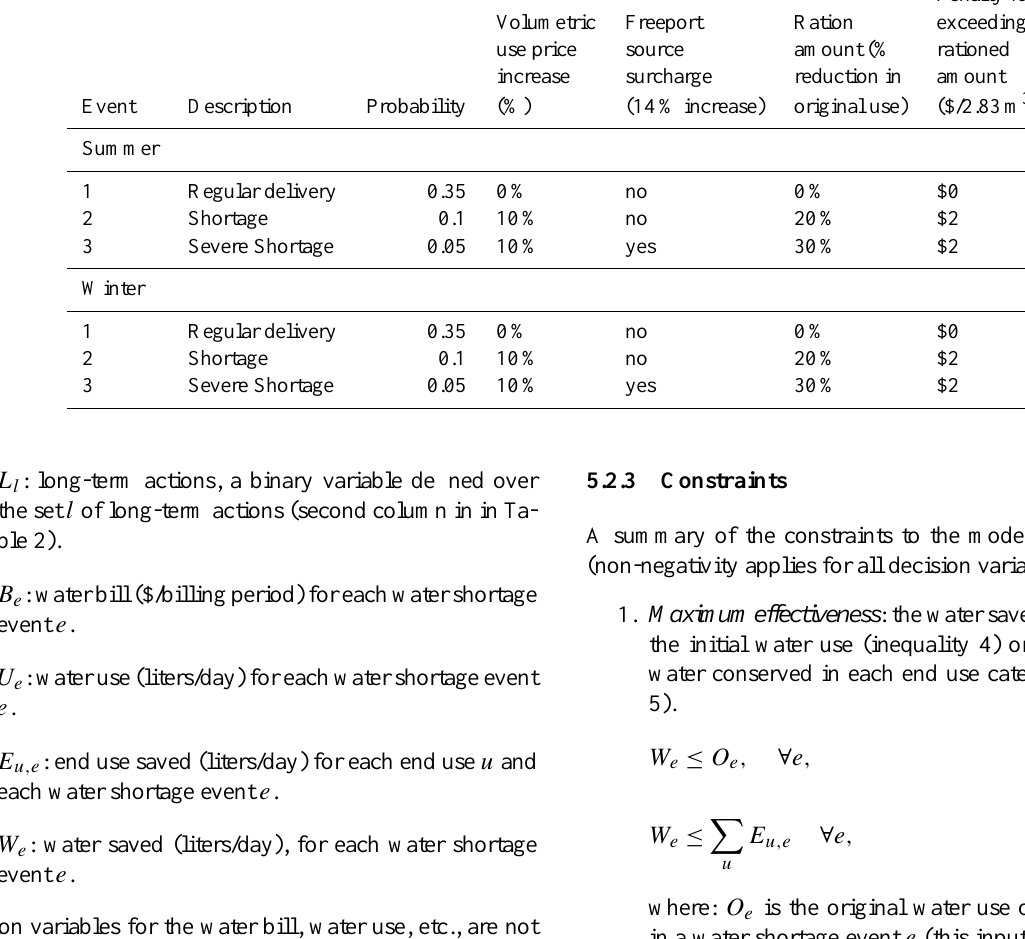
Volumetric Freeport Ration exceeding use price source amount (% rationed increase surcharge reduction in amount